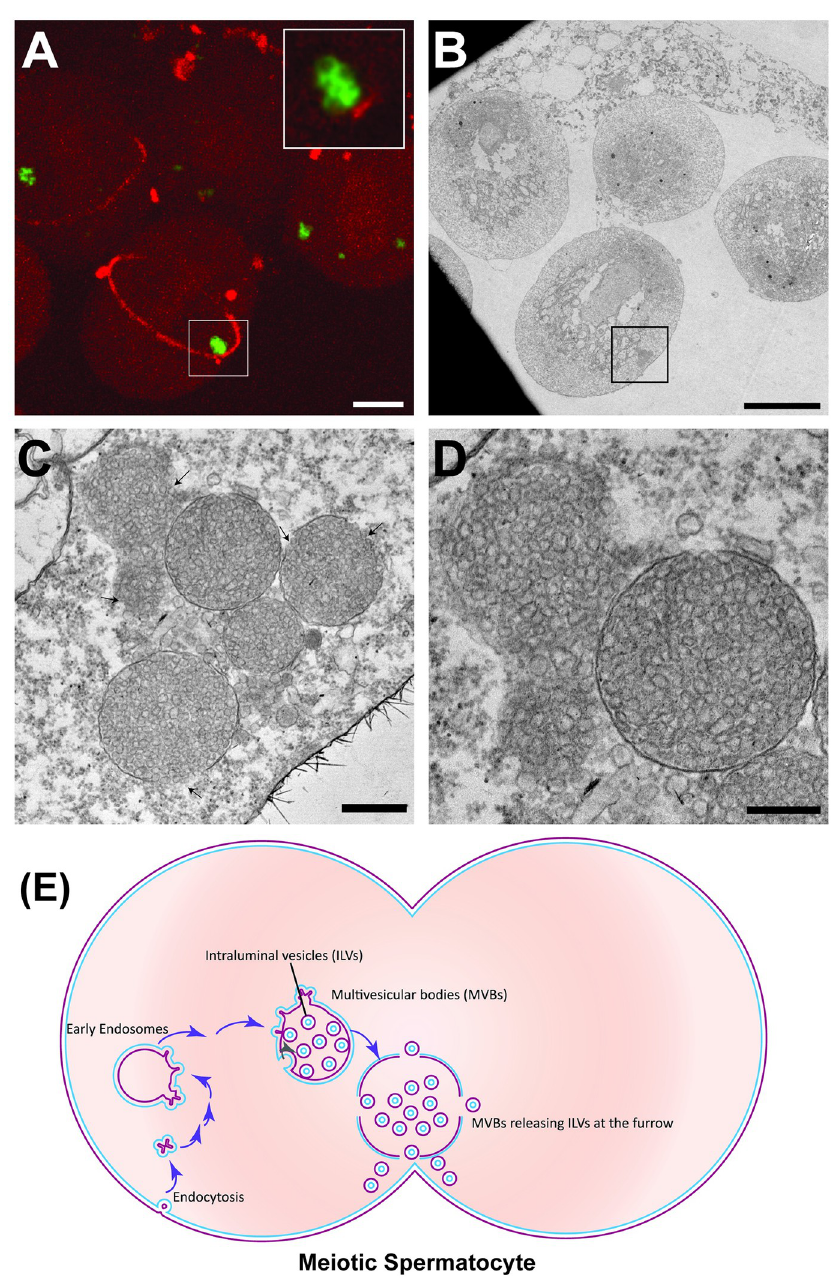
Fig 8. MVBs release intraluminal vesicles at the cytokinetic furrow. (A) Fluorescence maximum projection image capturing dividing cells from a dissected Drosophila cyst. Green, eYFP-Rab7; red, mRFP-Anillin. Inset, vesicles adjacent to a cleavage furrow. Scale bar: 10 μ m. (B) Corresponding TEM section. Endosomes adjacent to the cleavage furrow are boxed. Scale bar: 10 μ m. (C) Higher magnification TEM image of area boxed in B. Scale bar: 500 nm. Arrows indicate discontinuity in outer membranes of MVBs. (D) Subsequent TEM section of same area, showing make-up of vesicles at high magnification. Scale bar: 300 nm. (E) A model depicting endocytosis of CPE from plasma membrane, the maturation of these endosomes into multivesicular bodies, targeting and release of intraluminal vesicles at the cleavage furrow. CPE, ceramide phosphoethanolamine; MVB, multivesicular body.